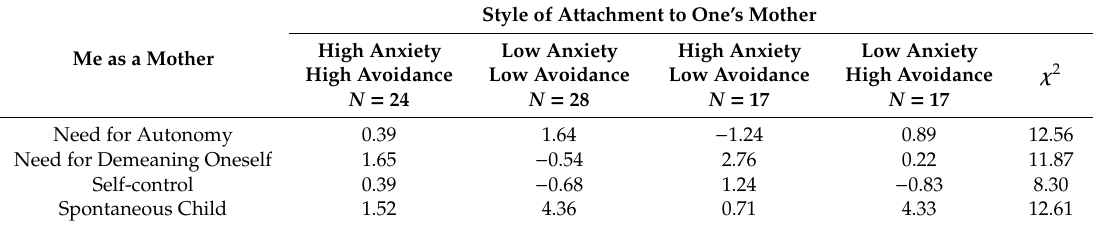
Table 1. Significant di ff erences in the representation of oneself as a mother among women with di ff erent styles of attachment to their mothers.